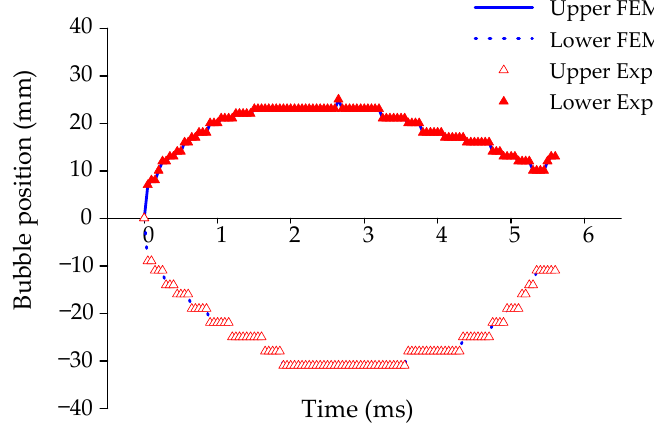
Figure 28. The position of the upper bubble surface and the lower bubble surface.